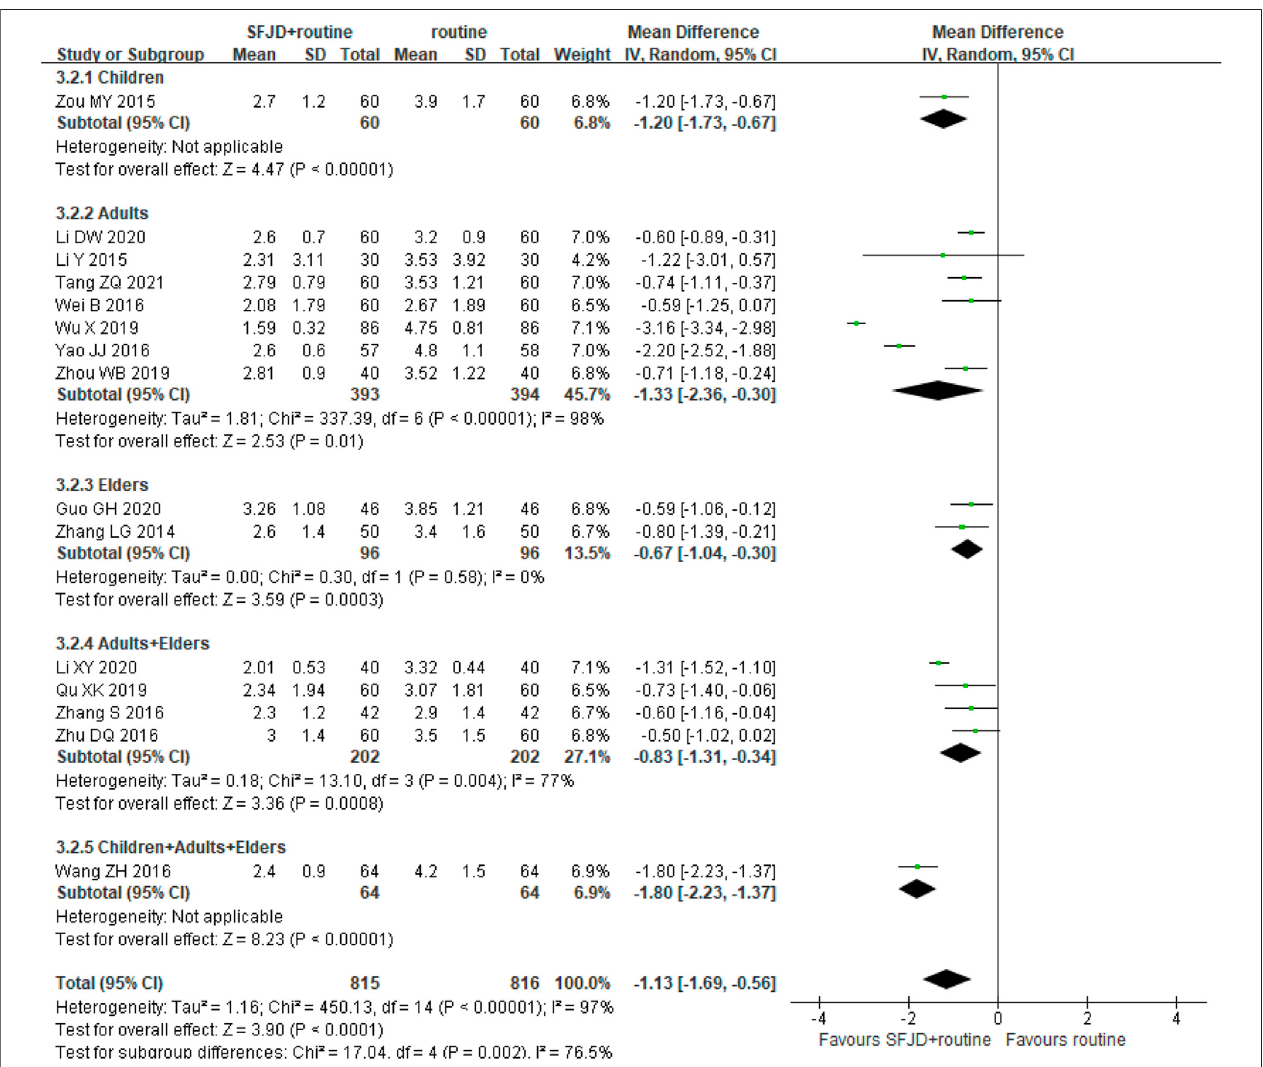
FIGURE 3 | Forest plot of resolution time (days) of fever strati fi ed by age. Comparison: SFJD plus routine treatment vs. routine treatment. SFJD: Shufeng Jiedu capsule.